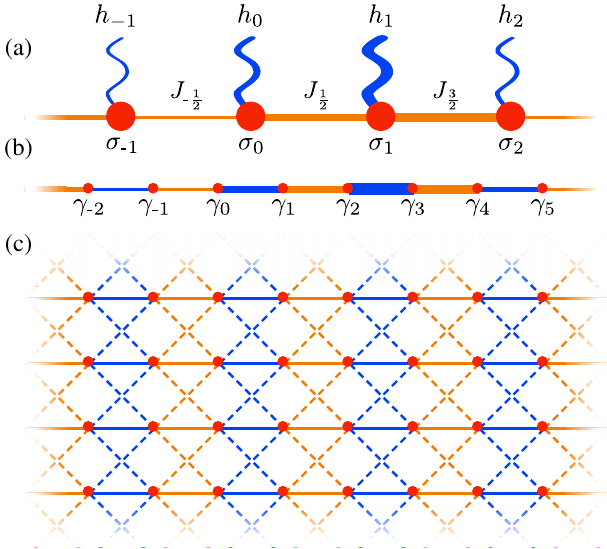
FIG. 2. (a) The transverse-field Ising chain with spatially varying fields h (blue) and bonds J (orange). (b) The i i þ 1 2 Jordan-Wigner transformation maps the spins σ to Majorana i fermions γ 2 , γ 2 arranged in a “ hopping ” chain. (c) The two- i i þ 1 dimensional hopping model Eq. (15) obtained by treating the phase ϕ as quasimomentum k and inverting the Fourier h y transformation. Each unit cell (of two sites) is pierced by uniform flux Q . The solid and dashed blue bonds have hopping strength h and A respectively, while the solid and dashed orange bonds h correspond to J and A J